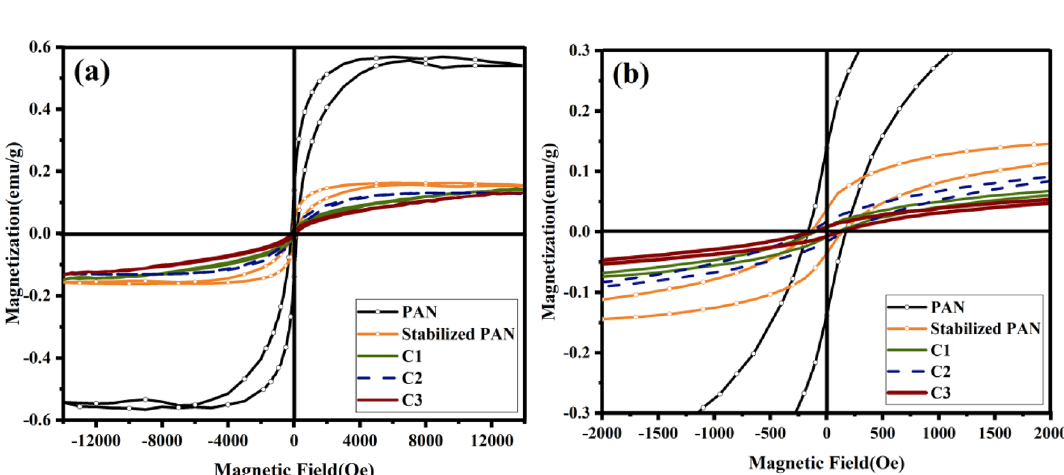
Figure 11. ( a ) Magnetization vs. magnetic field curve measured at room temperature of PAN-based carbon fibers, and ( b ) enlarged M–H curve of related